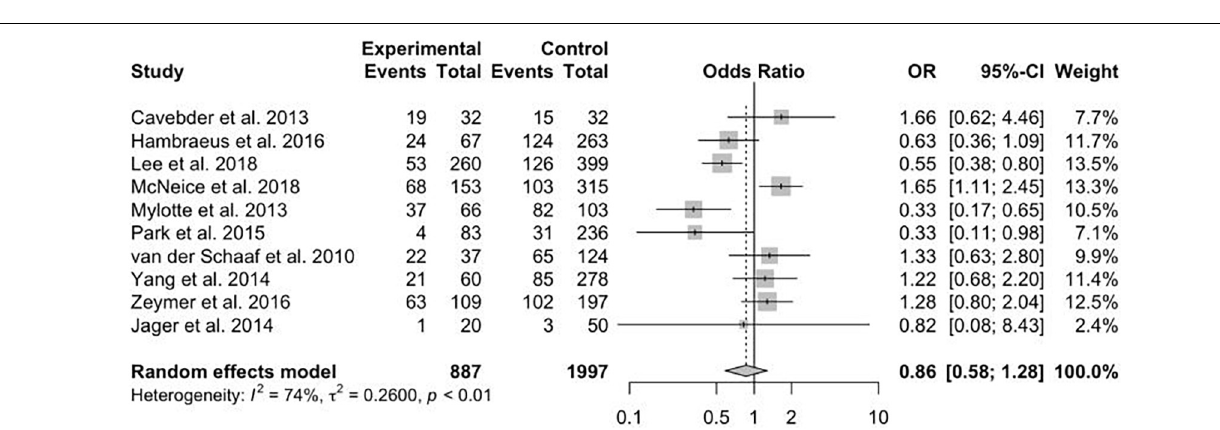
FIGURE 2 | Short-term mortality with multivessel (MV) vs. culprit vessel-only (CO) percutaneous coronary intervention (PCI) in patients with ST-segment elevation myocardial infarction (STEMI) complicated by cardiogenic shock (CS).